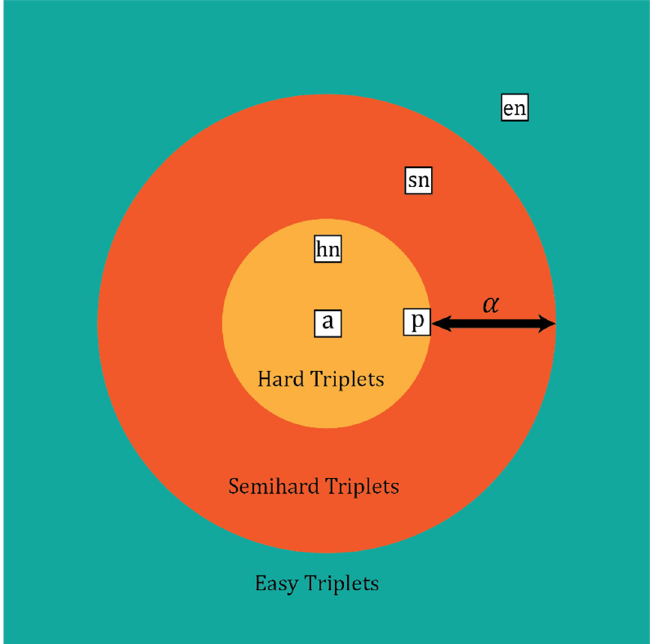
Figure 4. Easy, hard and semihard triplet illustration, a represent represents an anchor sample and p represents a positive sample; a hard triplet selects a negative in the hard triplet region; a semihard triplet selects a negative sample in semihard ( α ) region, and an easy triplet selects a negative sample in easy region.